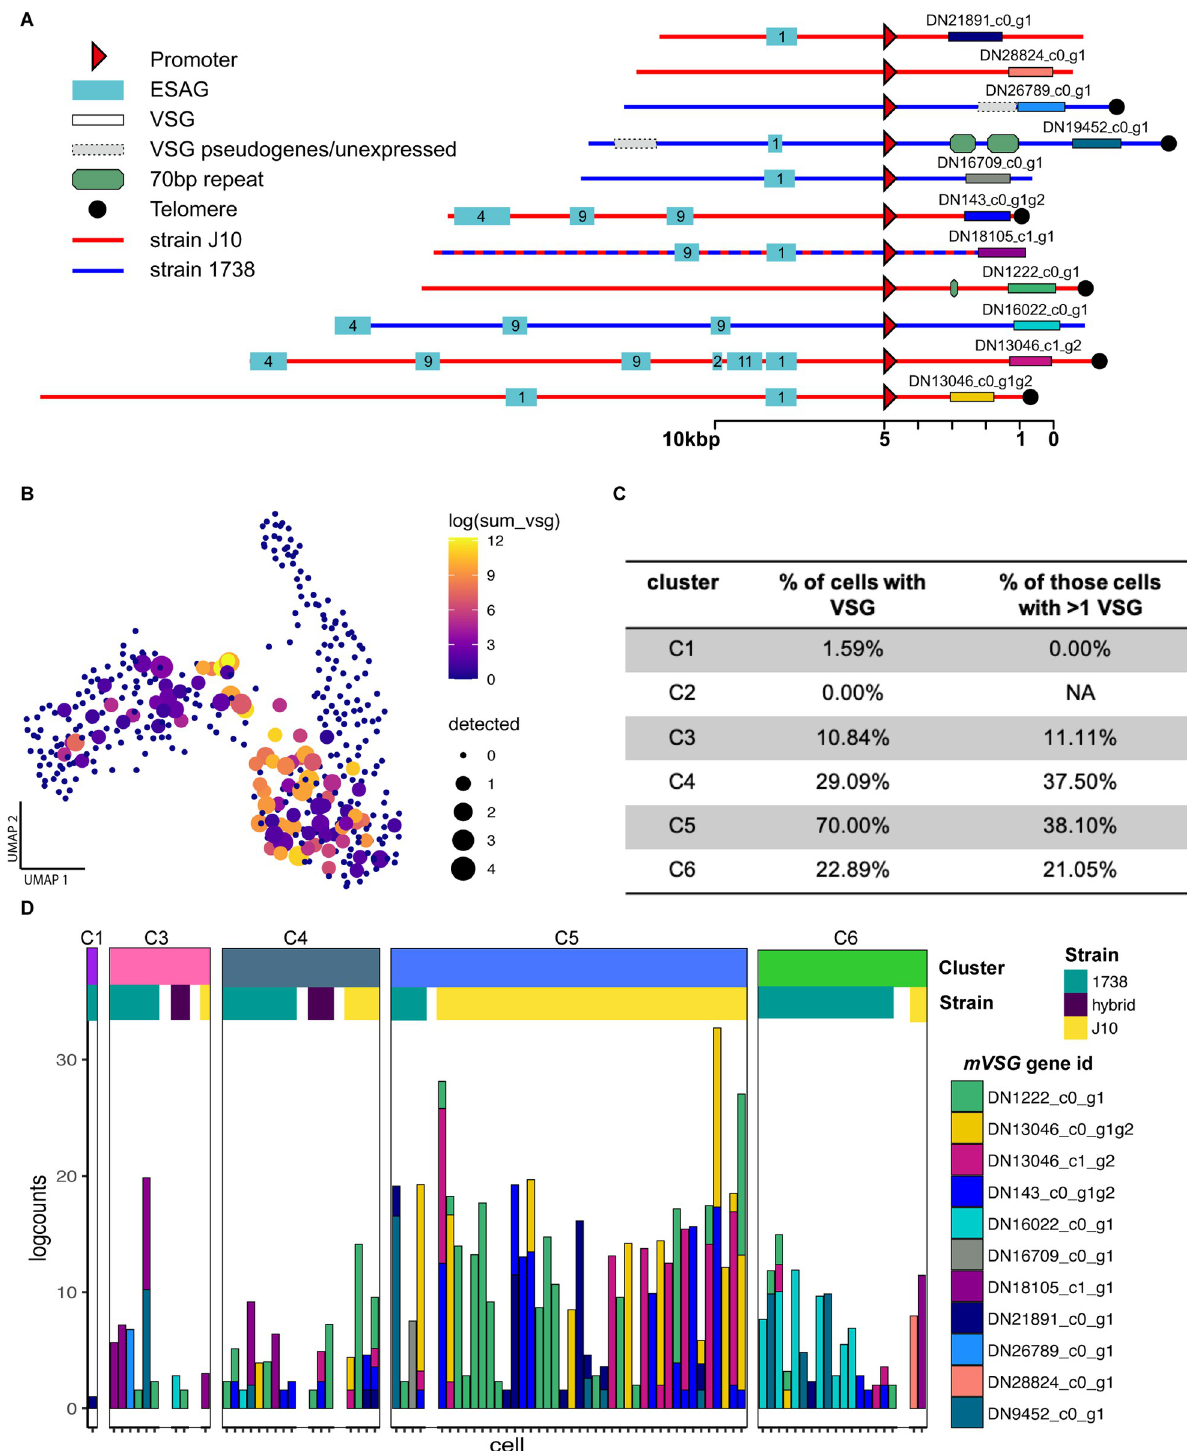
Fig 2. mVSG expression in fly-derived trypanosomes. (A) The genomic context of 11 mVSG s identified in strains 1738 and J10. The rectangles with a solid black outline represent the mVSG and are coloured to match Fig 2D. The sequences of each mVSG can be found in S1 File . (B) The transcript abundance of mVSG across 388 fly-derived trypanosome cells on the UMAP coloured by the logged sum of the mVSG counts in each cell and sized by the number of different mVSG detected in that cell. (C) The breakdown of mVSG expression per cluster. C5 had the highest proportion of cells expressing mVSG and the greatest proportion of those cells expressing multiple mVSG . (D) A barchart of all cells expressing mVSG ( > 1 read) organised by cluster and strain. Strain-specific expression of mVSG was seen at high levels in C5, which is primarily composed of strain J10. https://doi.org/10.1371/journal.ppat.1010346.g002 PLOS Pathogens| https://doi.org/10.1371/journal.ppat.1010346 March 7,